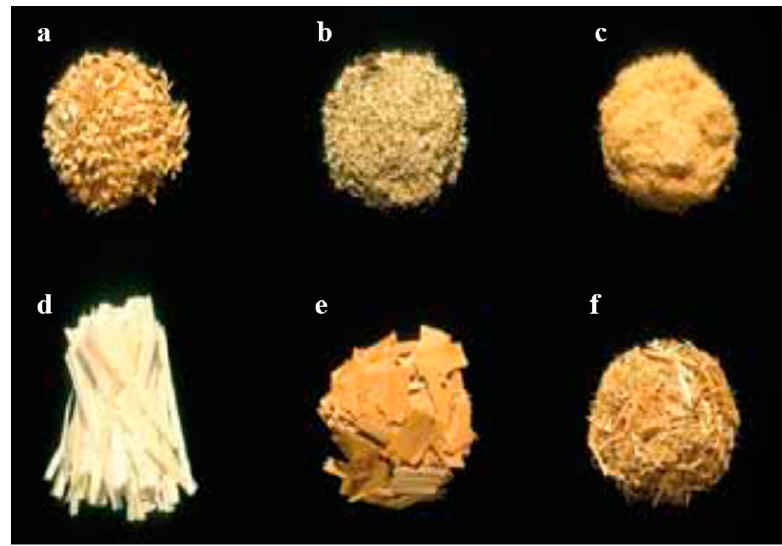
Figure 8. The types of form of kenaf fibers used in polymer composite production: ( a ) shavings, ( b ) sawdust, ( c ) fiber, ( d ) large particles, ( e ) wafers, and ( f ) strands. Source: Figure reproduced with copyright permission from Stark et al. (2010) [128]. Table 3. List of reported studies on kenaf fiber reinforcement in various forms and its applications. Type of Ther- Kenaf Part and Form